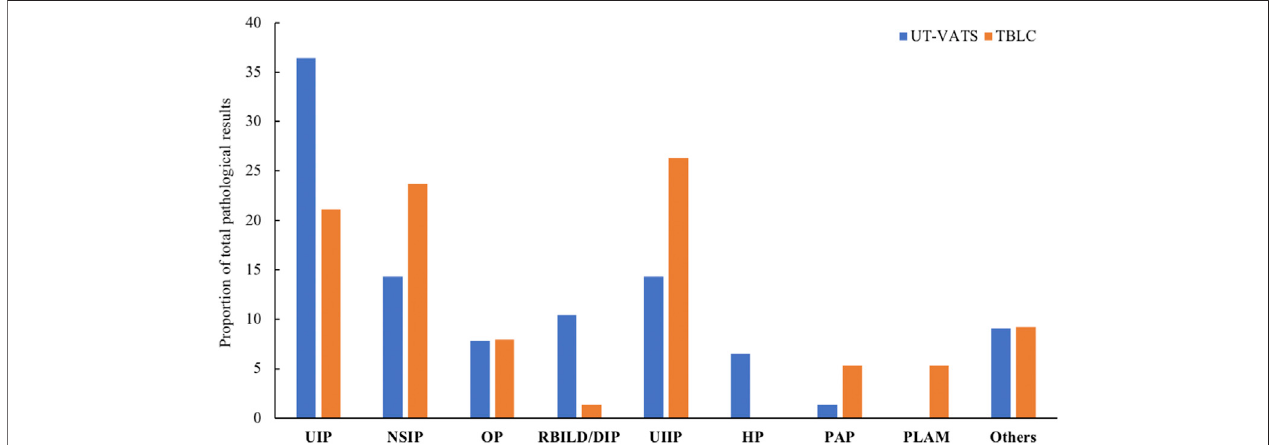
FIGURE 2 | The distribution of pathological diagnoses by different biopsy methods. UT-VATS: uniportal and tubeless-video-assisted thoracic surgery, TBLC: transbronchial lung cryobiopsy, UIP: usual interstitial pneumonia, NSIP: non-speci fi c interstitial pneumonia, OP: organizing pneumonia, RB-ILD: respiratory bronchiolitis interstitial lung disease, DIP: desquamative interstitial pneumonia, UIIP: unde fi ned interstitial pneumonia, HP: hypersensitivity pneumonitis, PAP: pulmonary alveolar proteinosis, PLAM: pulmonary lymphangioleiomyomatosis, Others: including LIP (lymphocyte interstitial pneumonia), sarcoidosis, PLCH (pulmonary Langerhans